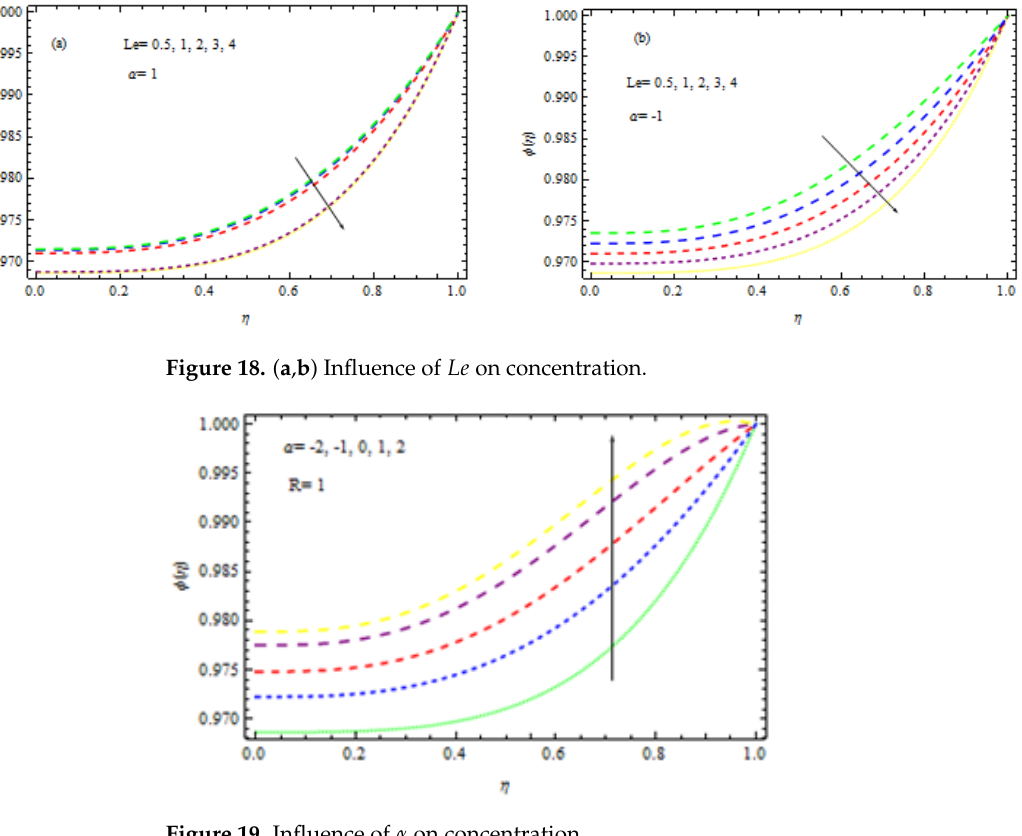
Figure 19. Influence of 𝛼 on concentration.